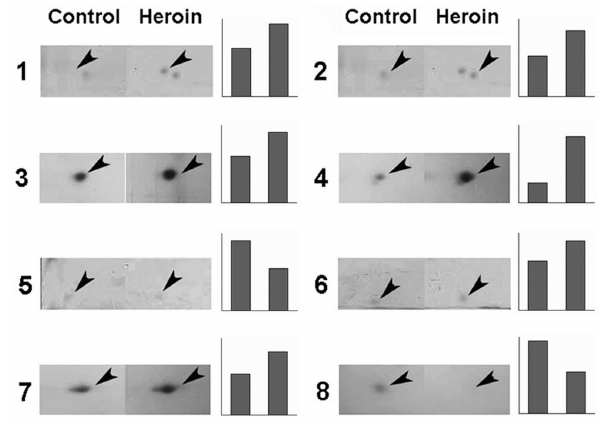
Figure 2. Relative abundance of eight differentially expressed proteins. Enlarged regions of the corresponding gels are shown for all 8 differentially expressed proteins. The proteins (No. 1–8) indicated by the arrows exhibited robust differences in their expression between the control group and heroin addict group. The graphs show the relative abundance of the proteins indicated across the two gels. The scales of